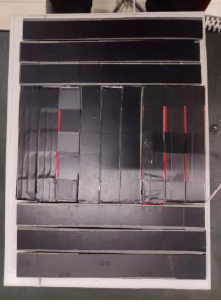
Figure 29. Traditional ferrite core in both primary and secondary sides.